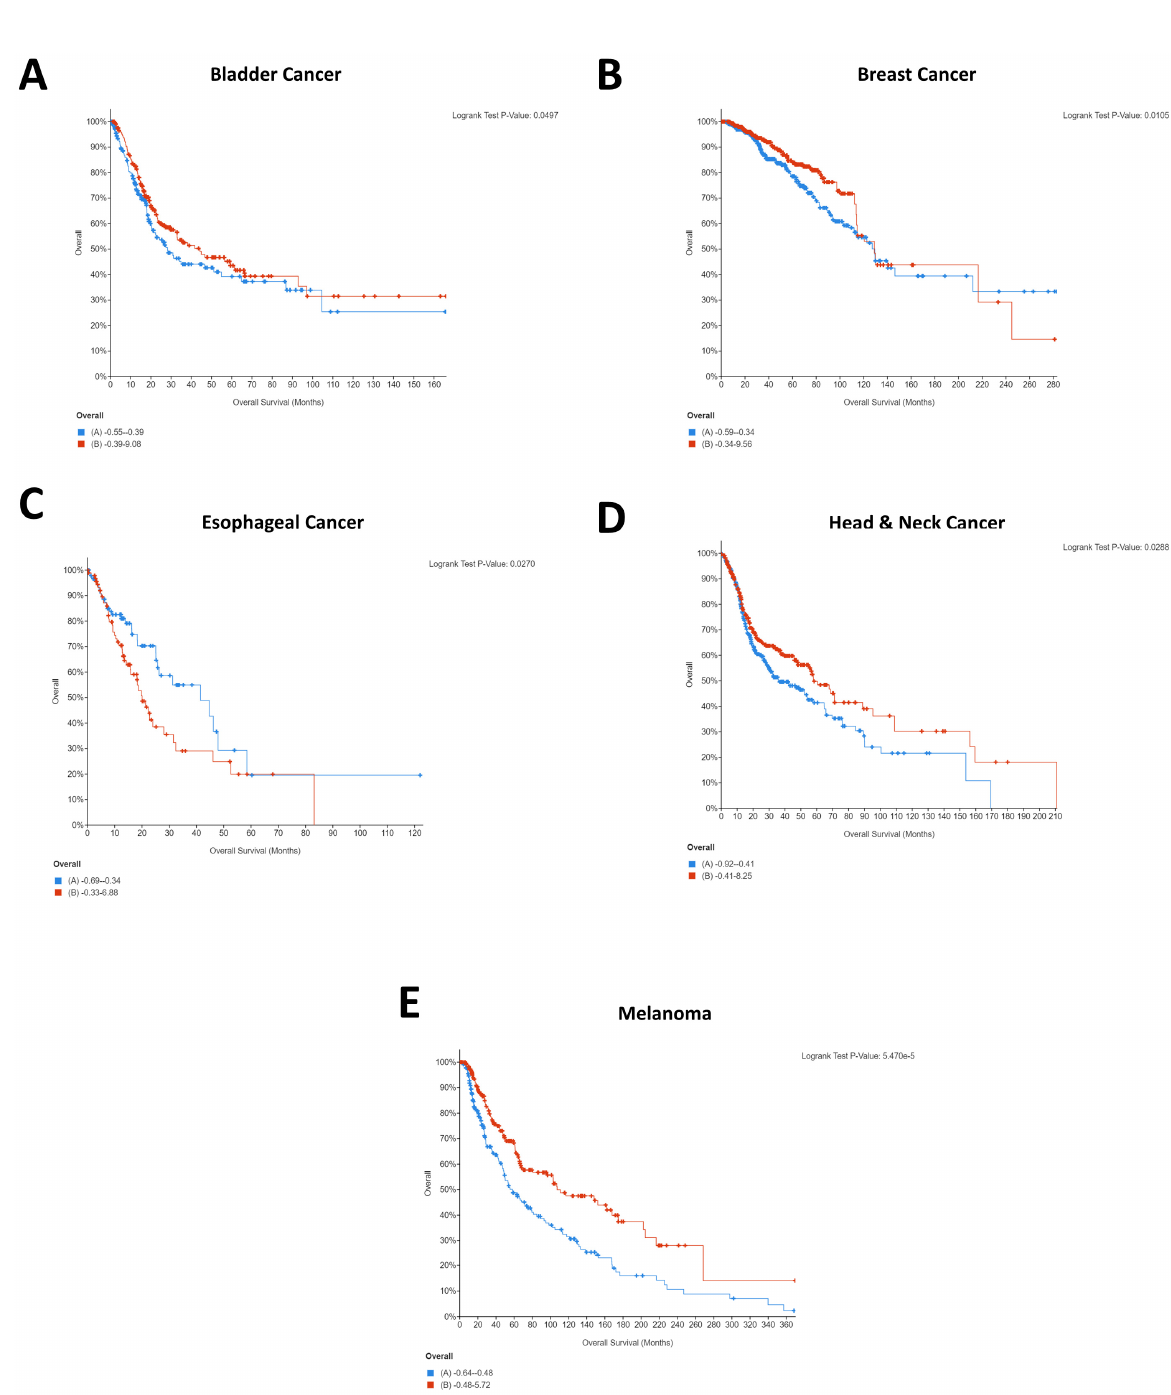
Figure 2. Statistically significant Kaplan–Meier plots for pan-cancer PDCD1 expression. In all cases, overall survival in months can be seen on the x -axis whilst percentage survived is shown on the y -axis. In all cases, high PDCD1 expression is shown in red whilst low PDCD1 expression is shown in blue. Data were generated using the mRNA expression z-scores relative to diploid samples (RNA Seq V2 RSEM) for the studies described in the Materials and Methods. PDCD1 expression was a significant factor for patient survival only in bladder cancer ( A ), breast cancer ( B ), esophageal cancer ( C ), head and neck cancer ( D ), and melanoma ( E ). As such, cervical, colorectal, gastric, liver, lung, lymphoma, mesothelioma, ovarian, renal, and pancreatic cancers have not been shown here but are available in Figure S2. Additionally, the mesothelioma study included (Mesothelioma (TCGA, Firehose Legacy)) lacked usable Kaplan–Meier survival